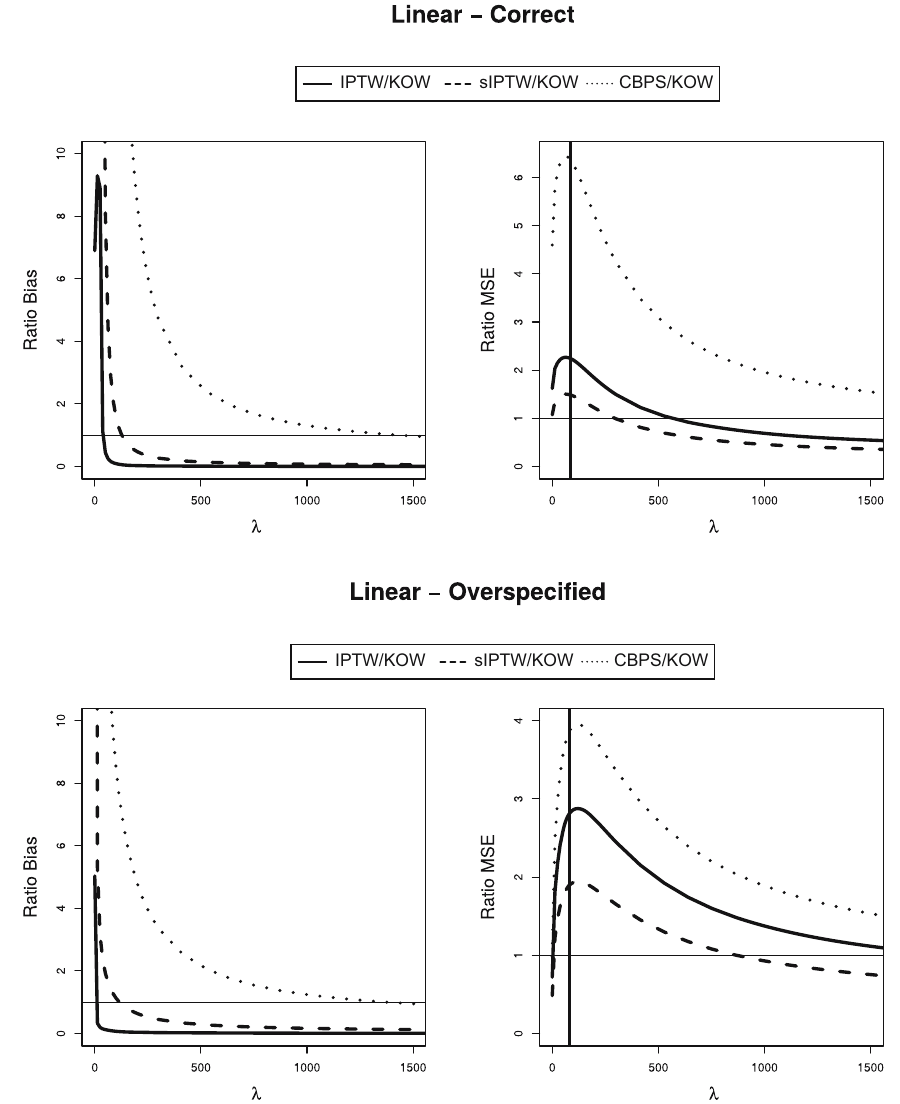
Figure 4: Ratios of squared biases and MSEs comparing KOW with IPTW ( solid ) , sIPTW ( dashed ) , and CBPS ( dotted ) across values of λ 0,…, 1,500 = in the linear - correct scenario ( top panels ) and in the linear - overspeci fi ed scenario ( bottom panels ) . Ratios above 1 means that KOW had a lower bias or MSE. Vertical bars show the mean value of λ , across simulations, obtained as described in Section